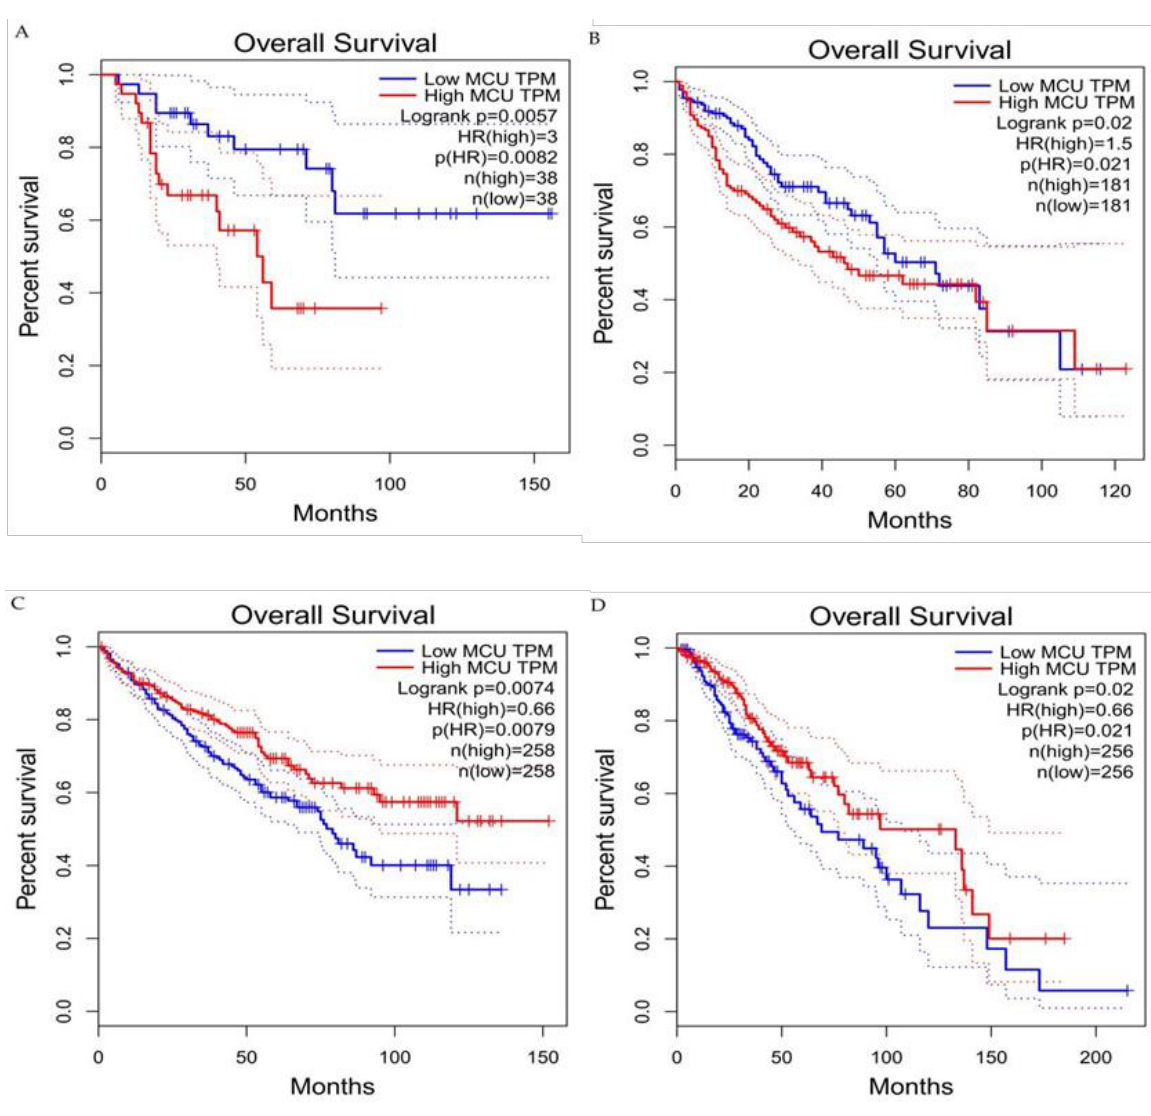
Figure 6. Survival curves for overall survival of high versus low expressing MCU. ( A ) Adrenocortical carcinoma. ( B ) Hepatocellular carcinoma. ( C ) Renal clear cell carcinoma. ( D ) Brain lower grade glioma. In adrenocortical carcinoma and hepatocellular carcinoma, overall survival is significantly greater in low MCU expression than in high MCU expression. In renal clear cell carcinoma and brain lower grade glioma, overall survival is significantly greater in high MCU expression than in low MCU expression. MCU, mitochondrial calcium uniporter; HR, hazard rate.